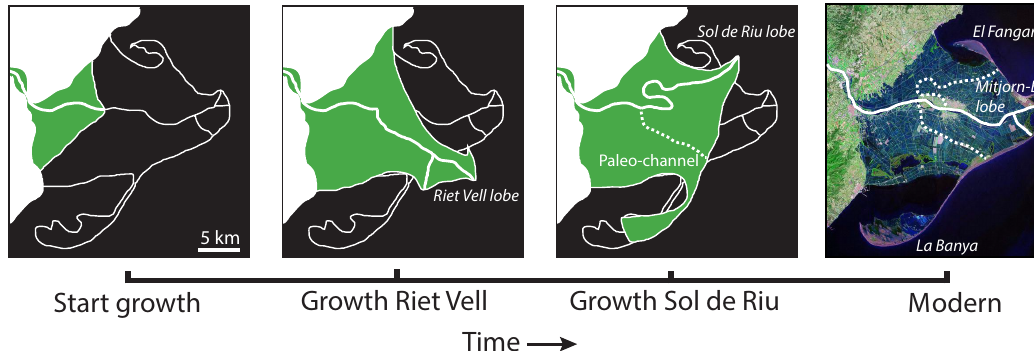
Figure 1. Reconstructed morphologic development of the Ebro Delta, modified from Canicio and Ibáñez (1999).